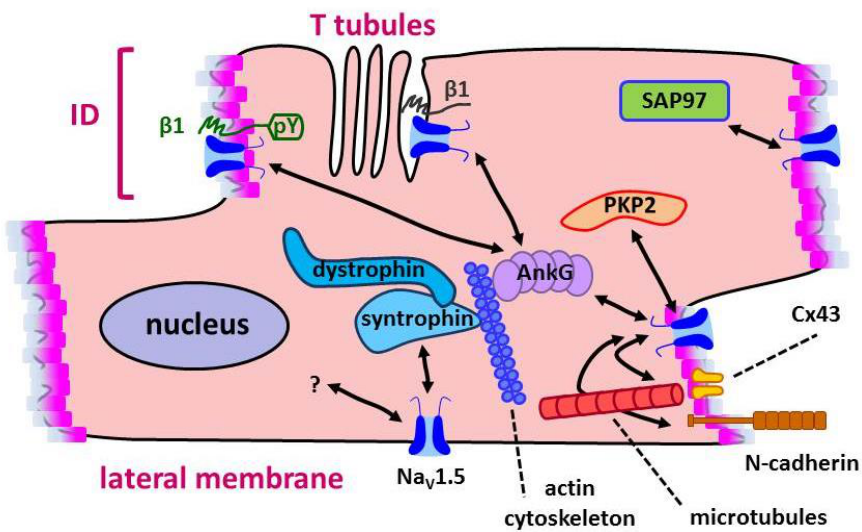
Figure 3. Multiple interactions implicating Na V 1.5 in cardiomyocytes. Several proteins have been identified interacting with Na V 1.5 in different subregions of the cardiomyocyte sarcolemma, establishing protein complexes that define different pools of Na V 1.5. See the text for details.